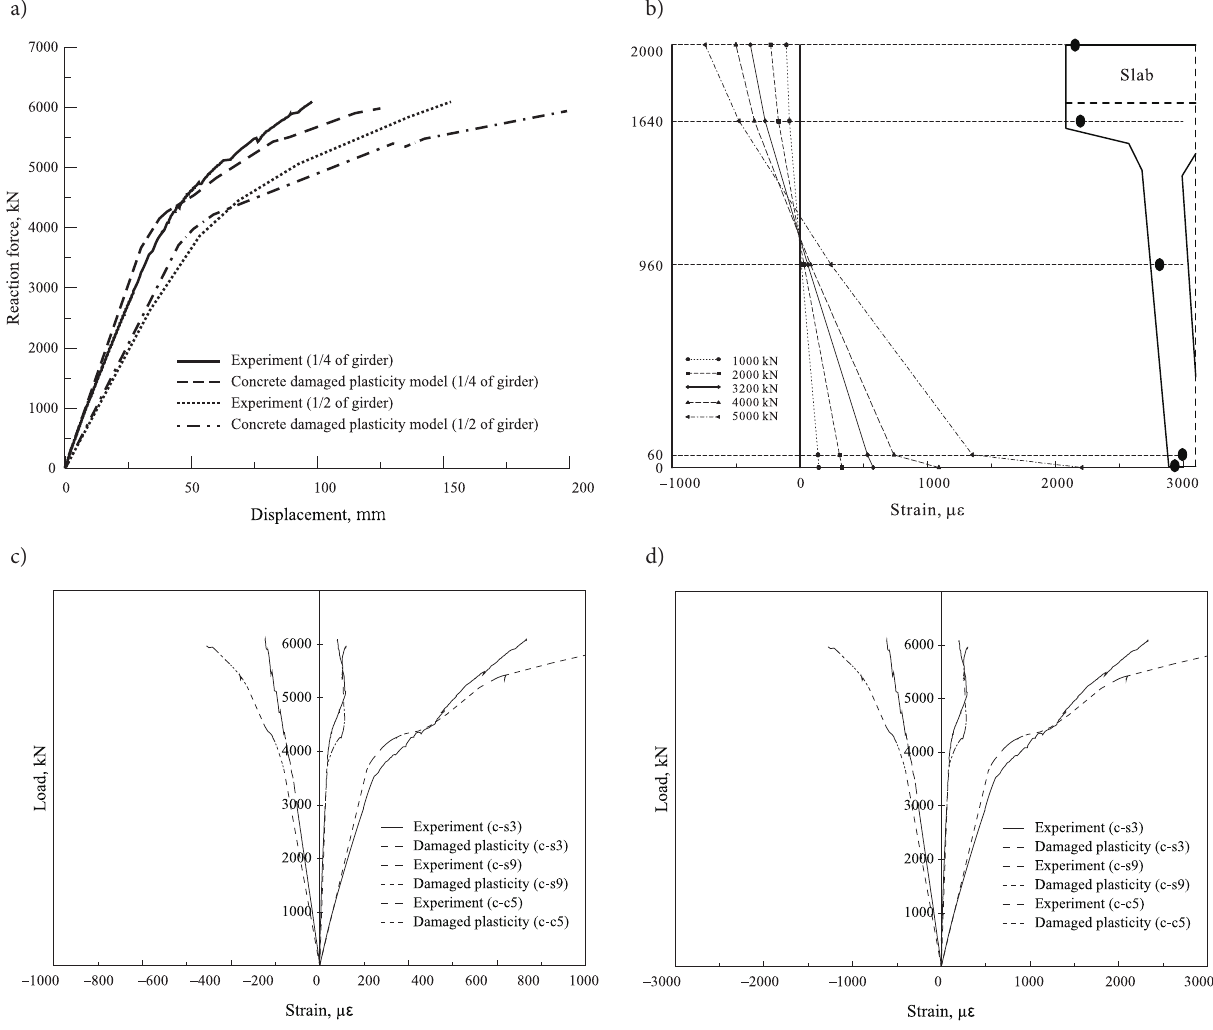
Fig. 5. Comparisons: a – applied load-central deflection curve at the central and the quarter sections: experiment vs. computer simulation; b – neutral axis migration due to progressive tension damages by increasing applied load, Longitudinal stress/strain curve at the level of the top, the center and the bottom point of the girder depth: cross-sections at c – L/4 and d